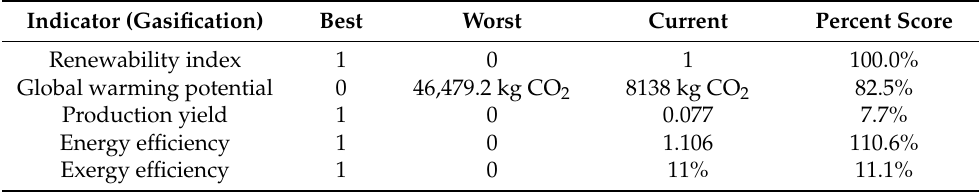
Table 7. Summary of targets, current value, and percent score of sustainability